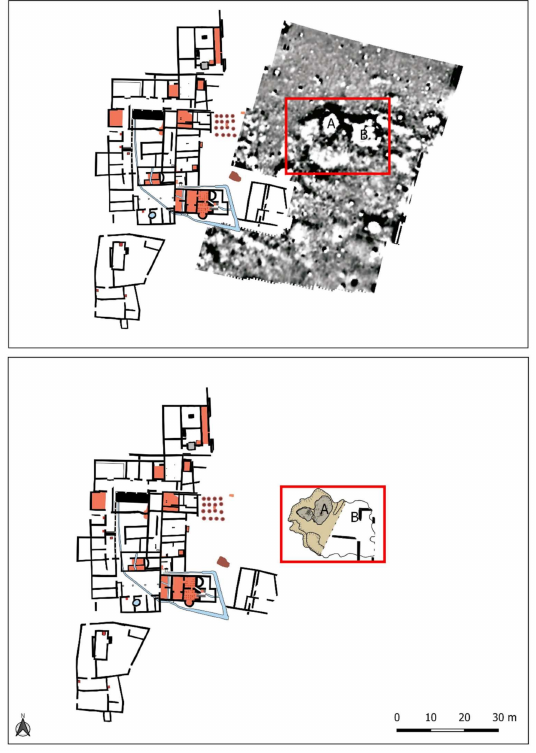
Figure 3. Location of the anomalies A and B detected by geophysical survey. Only anomaly A has been excavated till the